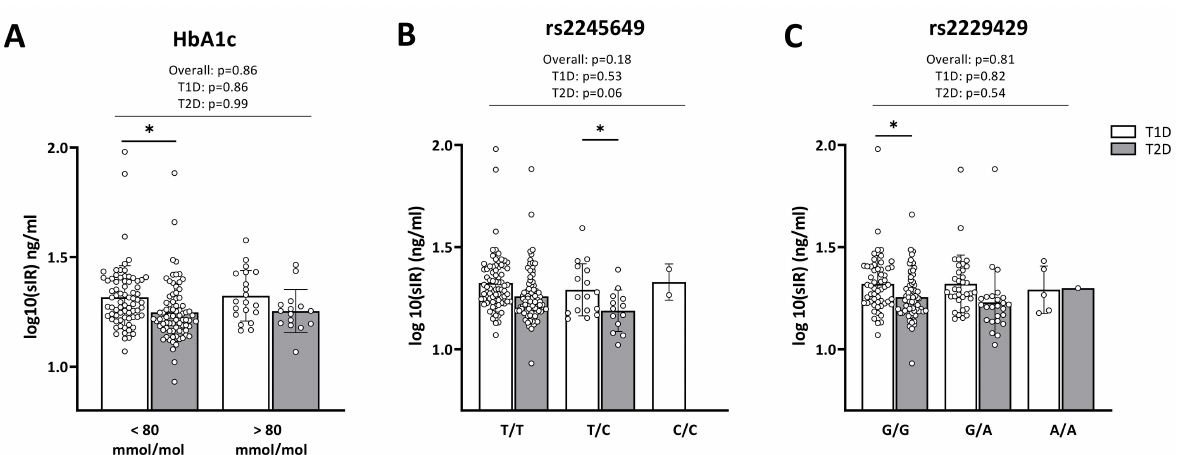
Figure 2. Serum sIR levels by HbA1c levels and INSR SNPs genotypes. Shown are serum sIR levels of patients with T1D ( n = 82, white bars) and patients with T2D ( n = 94, grey bars) in relation to ( A ) HbA1c levels (mmol/mol), ( B ) INSR rs2245649 and ( C ) INSR rs2229429. Trend tests and comparisons between T1D and T2D were performed with linear regression, adjusted for age and sex, * p ≤ 0.05.